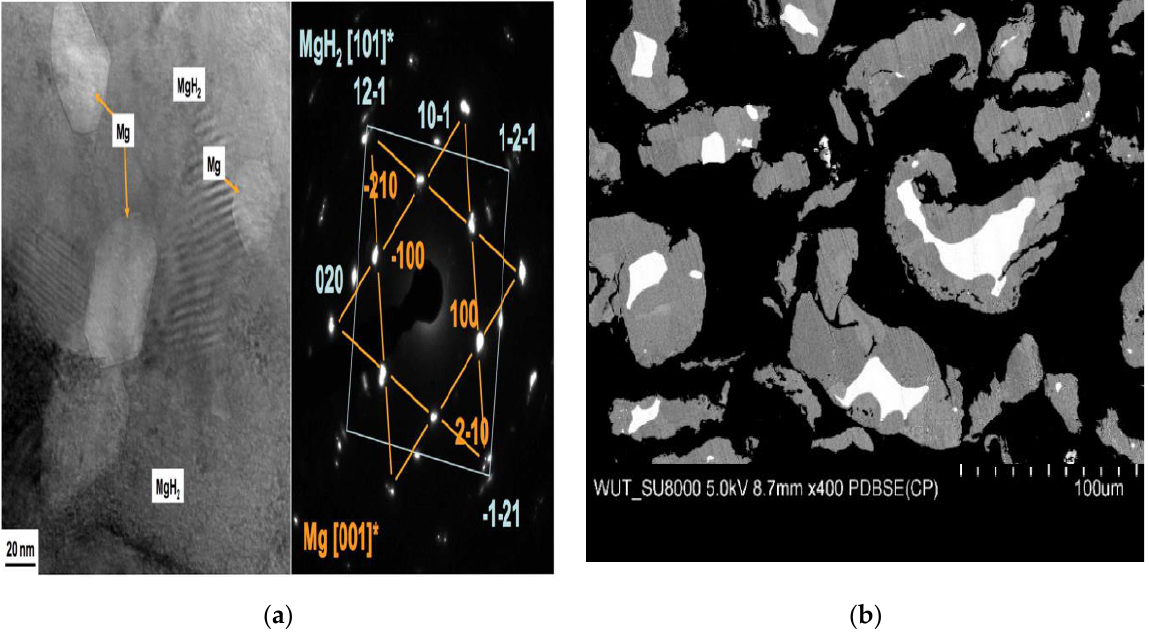
Figure 10. ( a ) A TEM image and selected area electron diffraction patterns from Mg and MgH 2 phases in a nominally fully hydrogenated bulk MgH 2 (hydrogen absorption at 350 ℃ and 2 MPa for 20 h) [55]; ( b ) Cross-section of commercially available magnesium hydride particles with visible white magnesium cores [88].